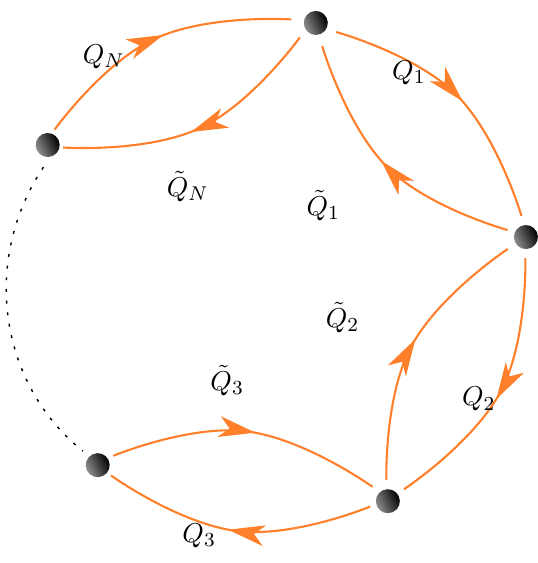
Figure 2 . The U(1) N = U(1) gauge theory that is mirror dual to SQED N